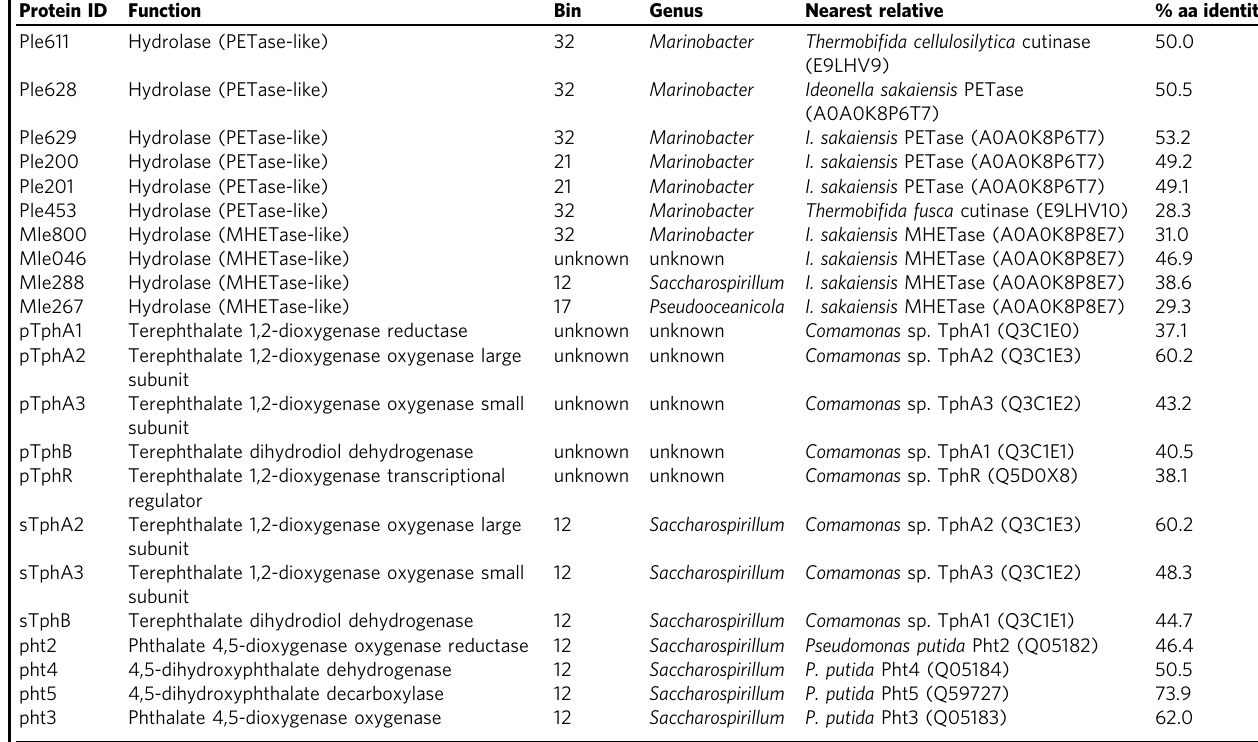
Table 1 Identi fi cation of PF degradation genes. Protein ID